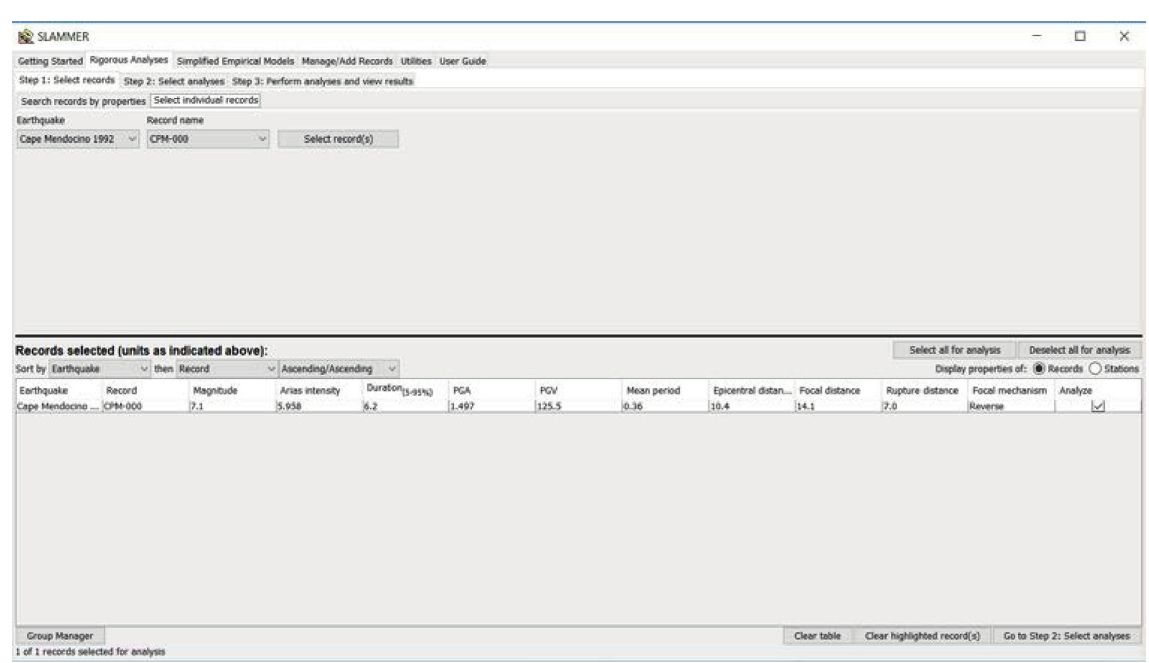
Figure 3: Soil properties from